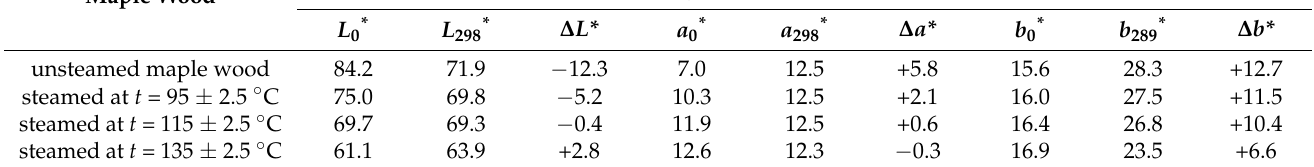
Table 2. Sizes of changes in ∆ L* , ∆ a* , ∆ b* values in the CIE L*a*b* color space of unsteamed